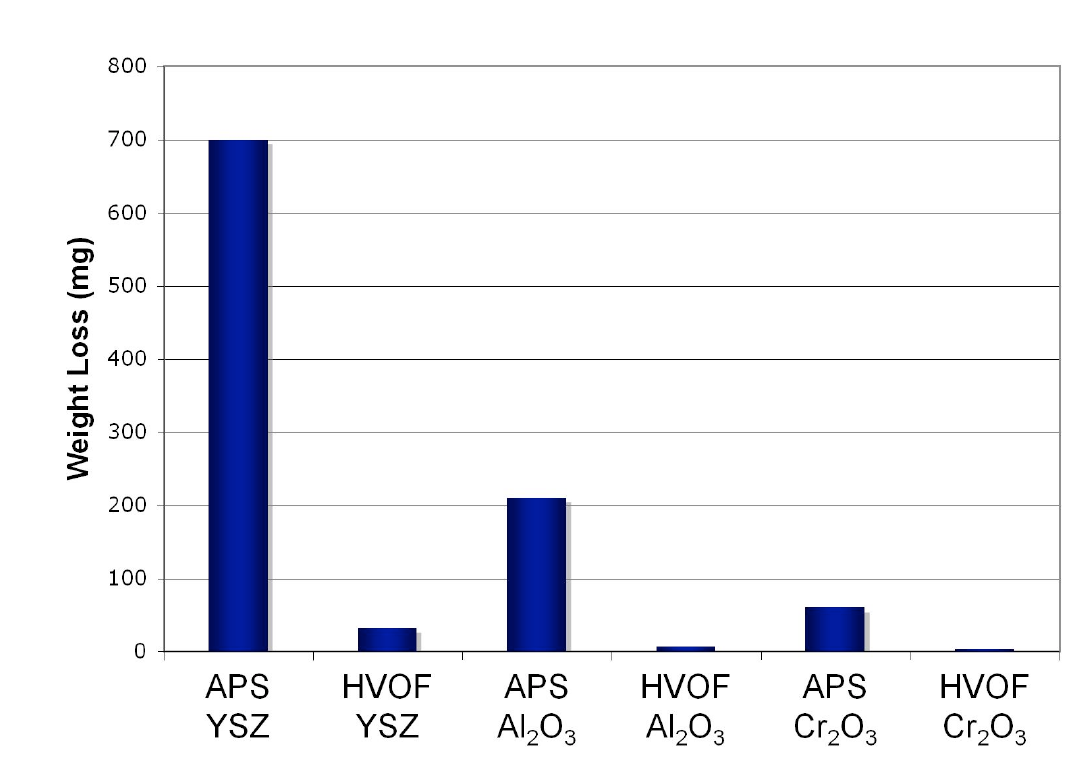
Figure 11. Comparison of abrasive wear resistance of plasma sprayed and HVOF sprayed oxide ceramic coating coatings: yttria-stabilized zirconia (YSZ), aluminia (Al chromia (Cr O ). Compiled based on 2 3